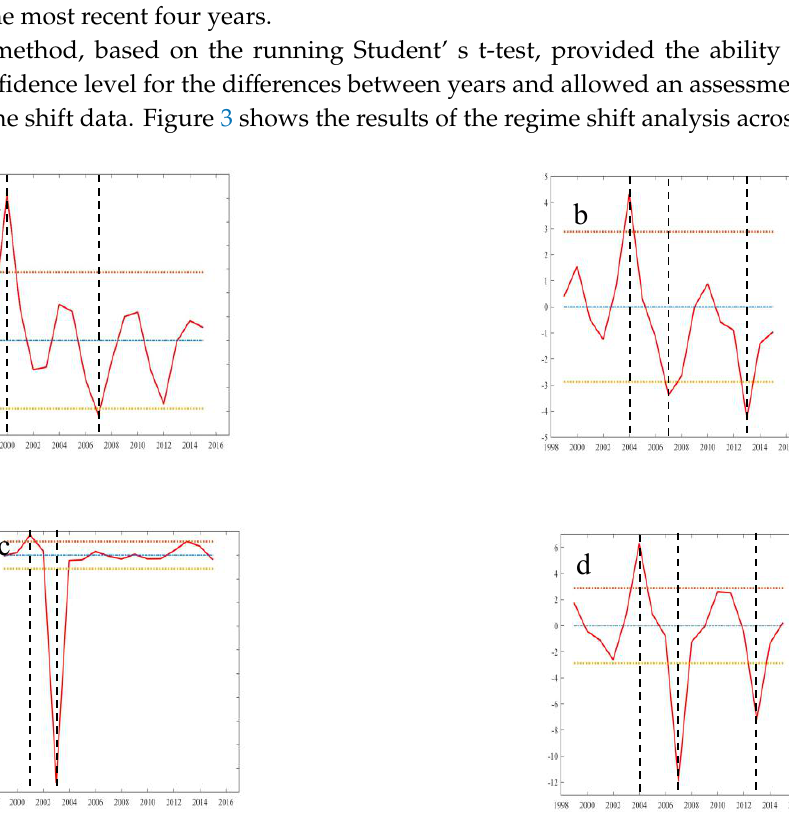
Figure 2. Inter ‐ annual variation in the trends of the WPI TN , WPI TP , WPI DO , and WPI COD : ( a ) WPI TN ; ( b ) WPI TP ; ( c ) WPI DO ; ( d ) WPI COD .